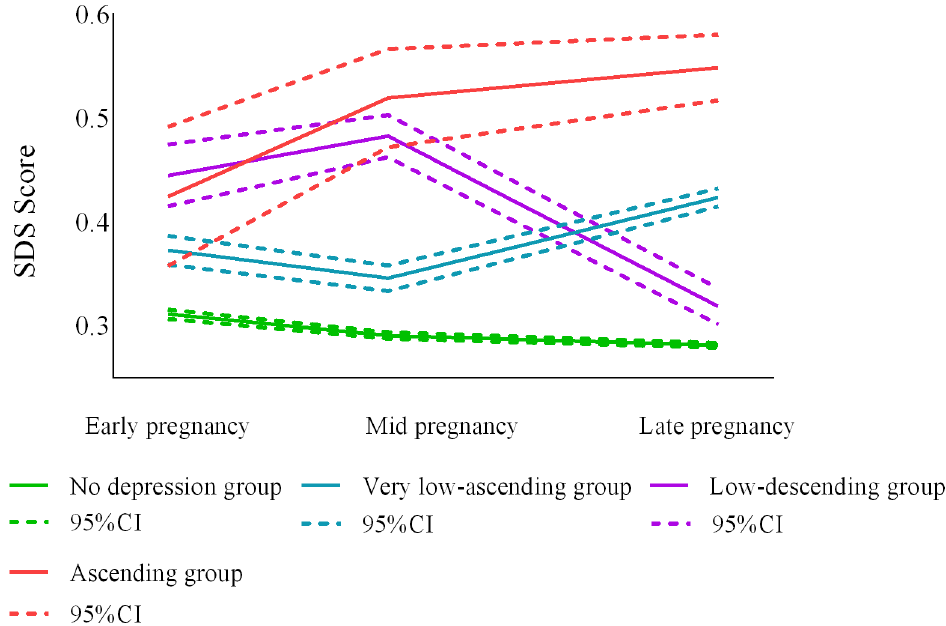
Figure 3. Optimal model trajectory curves for prenatal depression (n = 916).